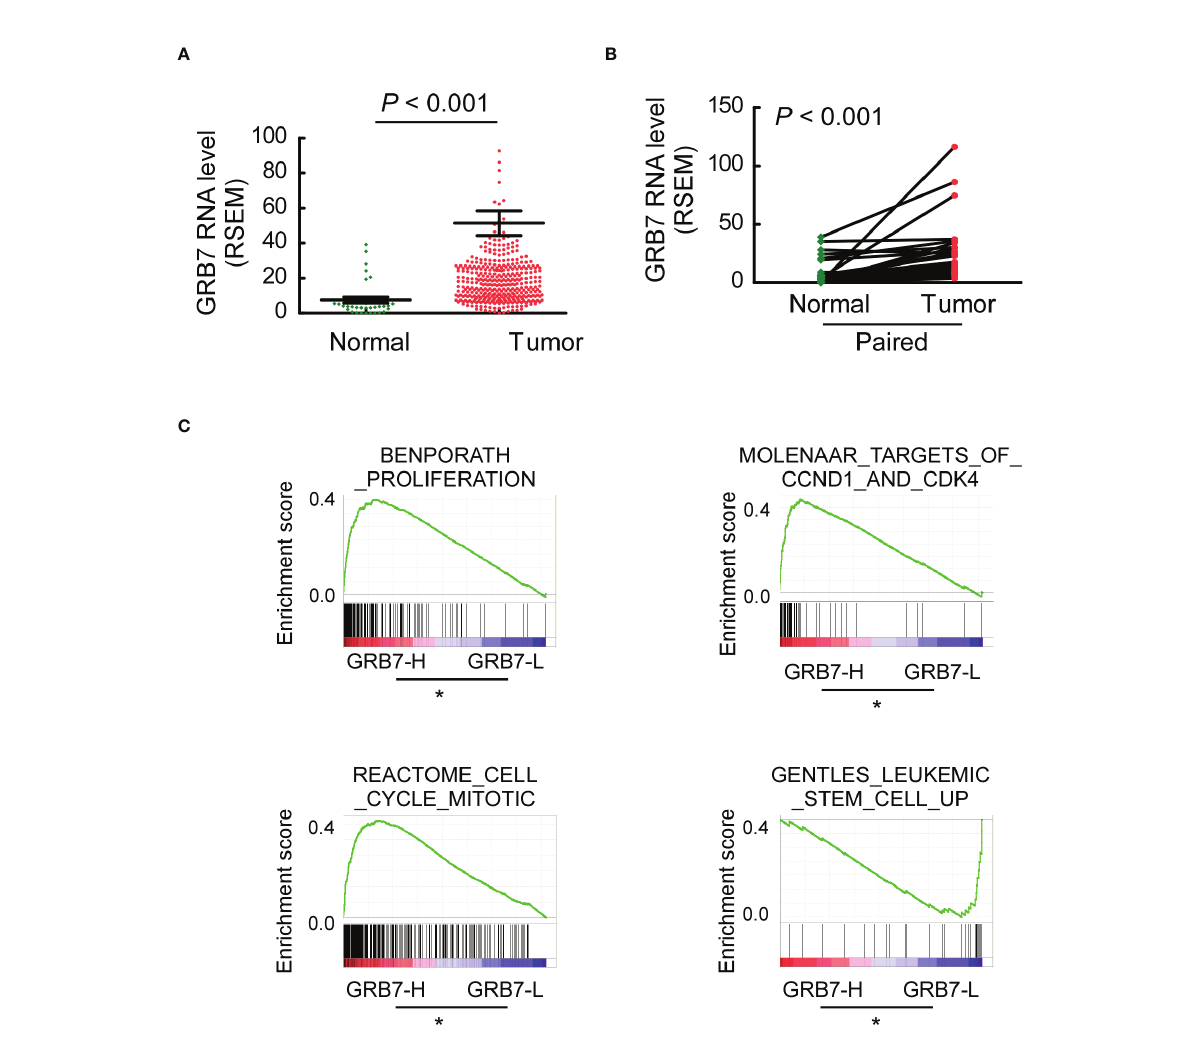
FIGURE 3 TCGA data indicates the expression trend of GRB7 and the potential correlation with the proliferation and stem cell characteristics. (A) GRB7 was signi fi cantly higher in 409 cases of gastric cancer than in 37 cases of normal gastric tissue. (B) GRB7 in gastric tumor tissue was signi fi cantly higher than that in matched tissue from the same patient. (C) GSEA analysis showed that GRB7 was positively correlated with the events of accelerating cell growth and increasing stem cells.